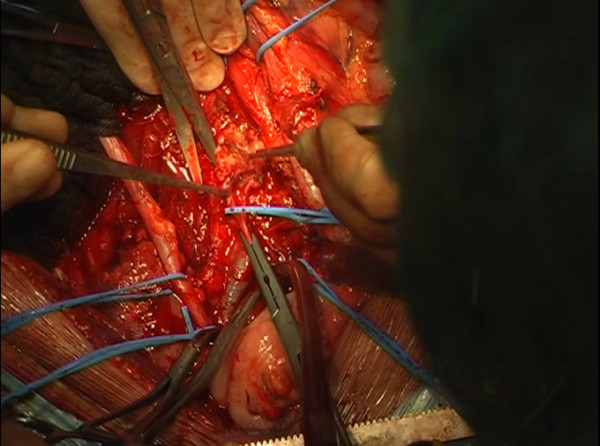
The segment of inferior vena cava infiltrated by the mass is then removed.